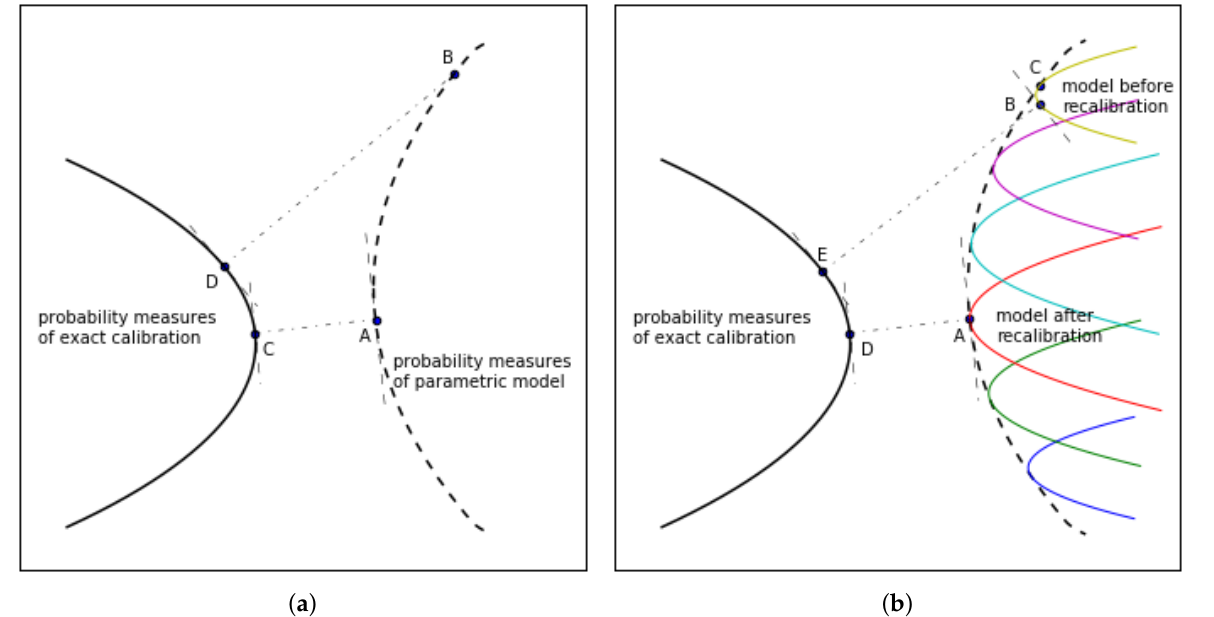
Figure 1. Graphic illustration of the mathematical definitions of model risks for ( a ) observable state variable, ( b ) latent state